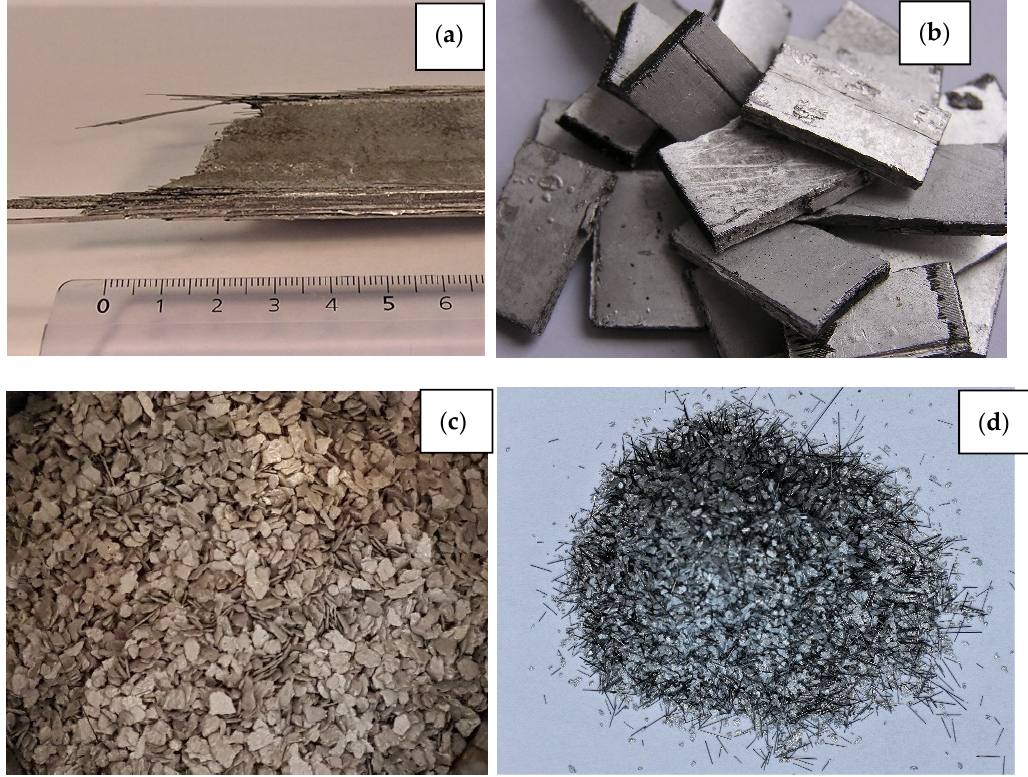
Figure 4. Stages of Al-W-B waste shredding: breaking ( a ) and cutting the plates ( b ); shredding and milling the material ( c , d ).